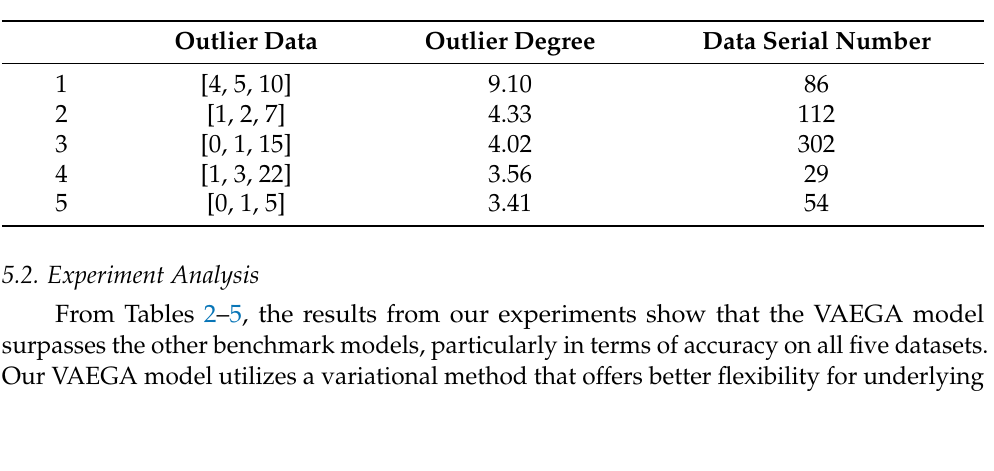
Table 6. An example: abnormal subspace ‘V4,V5,V10’ in the ground truth of the abnormal subspaces for the